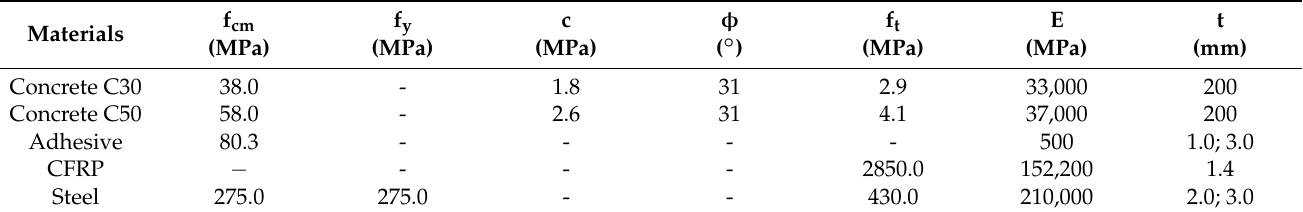
A summary of the materials properties used in FE models are listed in Table 1. Table 1. Geometrical and mechanical properties of materials used in the FE.